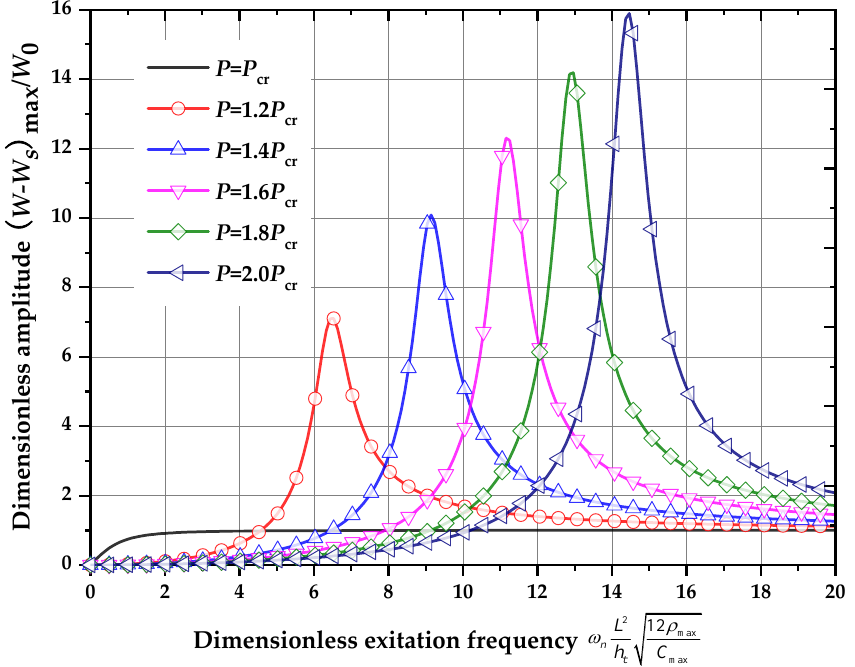
Figure 9. Dimensionless vibration amplitude-excitation frequency curves for different axial load at